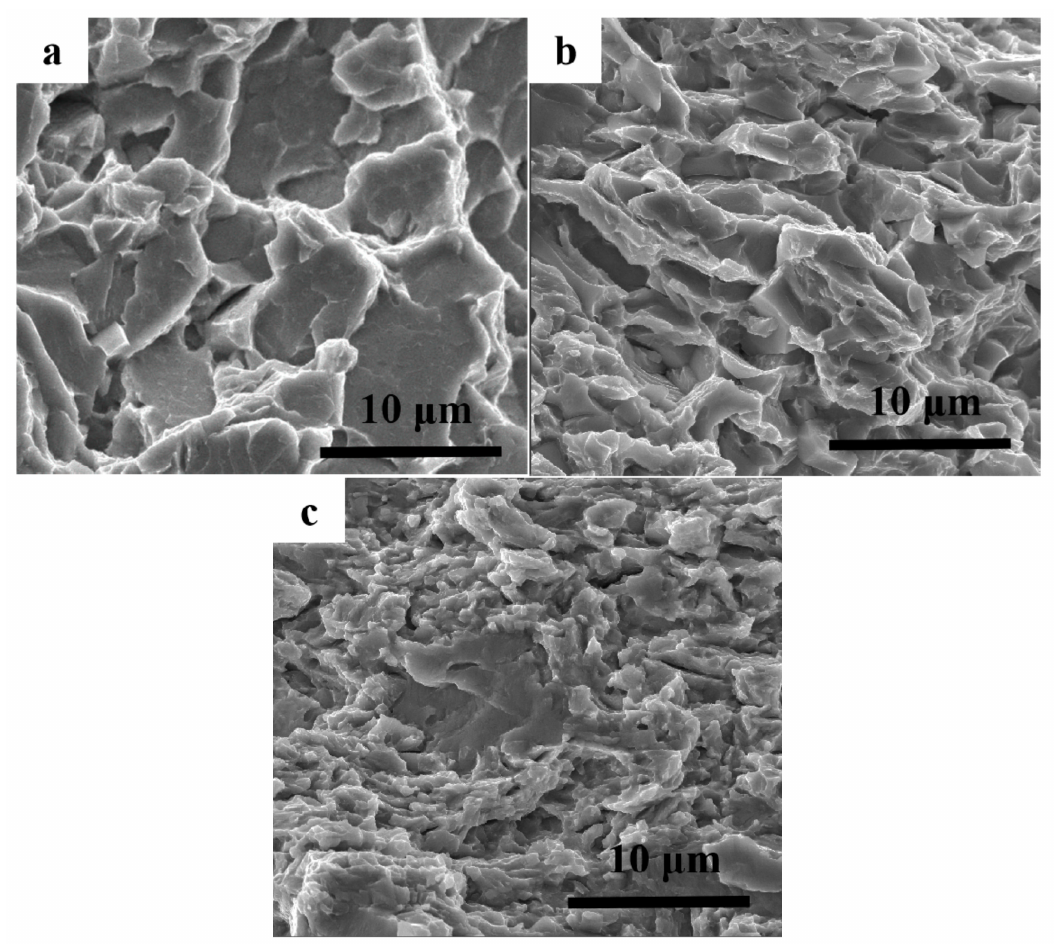
Figure 7. Tensile fracture morphologies of the Zn-0.5%Li-0.1%Ag alloy in different treatment states: ( a ) as-cast, ( b ) extruded, and ( c )